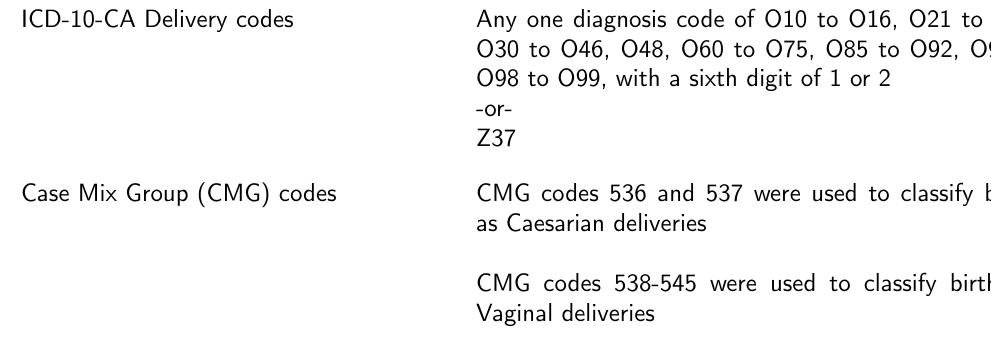
Supplementary Table 1: ICD-10-CA codes used to identify deliveries, and Case Mix Group CMG codes used to identify C-section births.